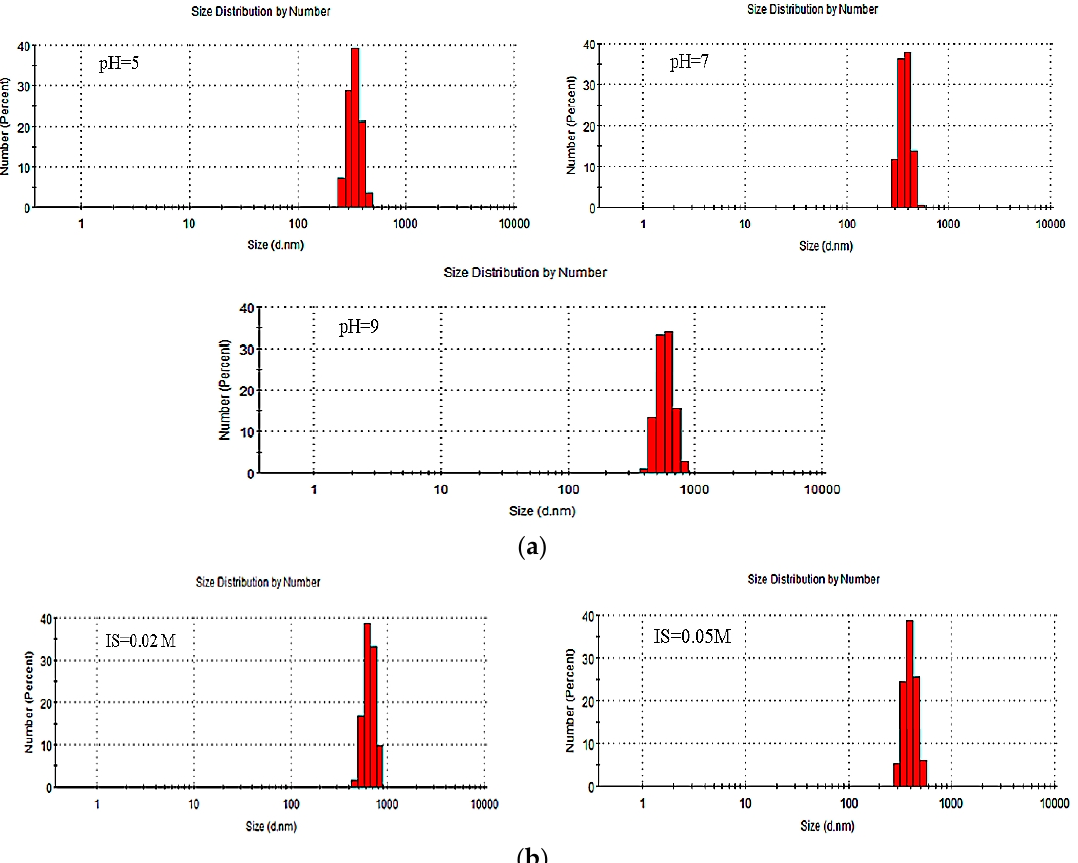
Figure 1. Particle size distribution of silica colloid under different conditions. ( a ) Particle size distribution of silica colloid particles under different pH conditions (IS = 0.00 M); ( b ) Particle size distribution of silica colloid under different IS conditions (pH = 7).